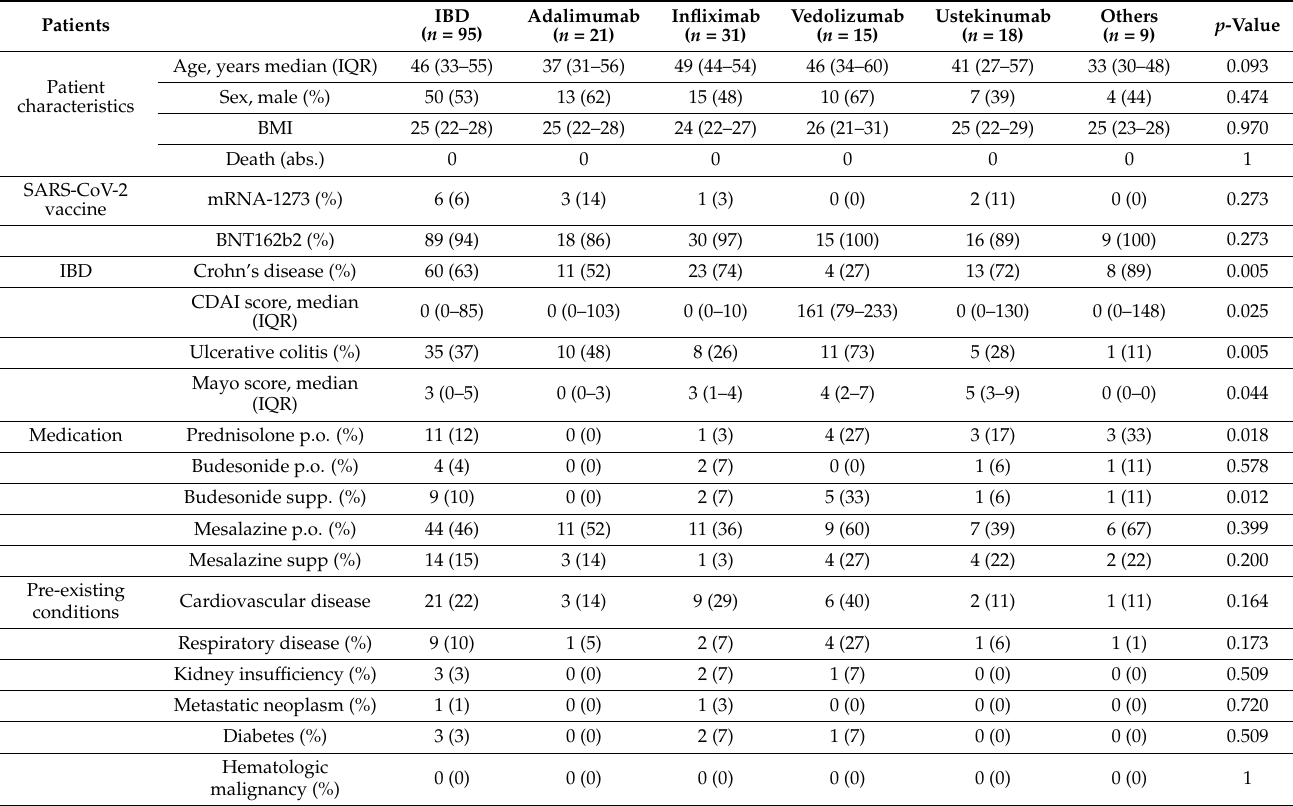
Table 1. Cohort characteristics of IBD patients. Representation of the entire IBD patient cohort and classification of patients by immunosuppressive therapy (adalimumab, infliximab, vedolizumab, azathioprine, ustekinumab, and others). The following immunosuppressants were summarized under “others”: corticosteroids, tofacitinib, certolizumab, golimumab, risankizumab, etrolizumab, mycophenolate mofetil, and azathioprine. IBD: inflammatory bowel disease; IQR: interquartile range; BMI: body mass index; SARS-CoV-2: severe acute respiratory syndrome coronavirus 2; CDAI